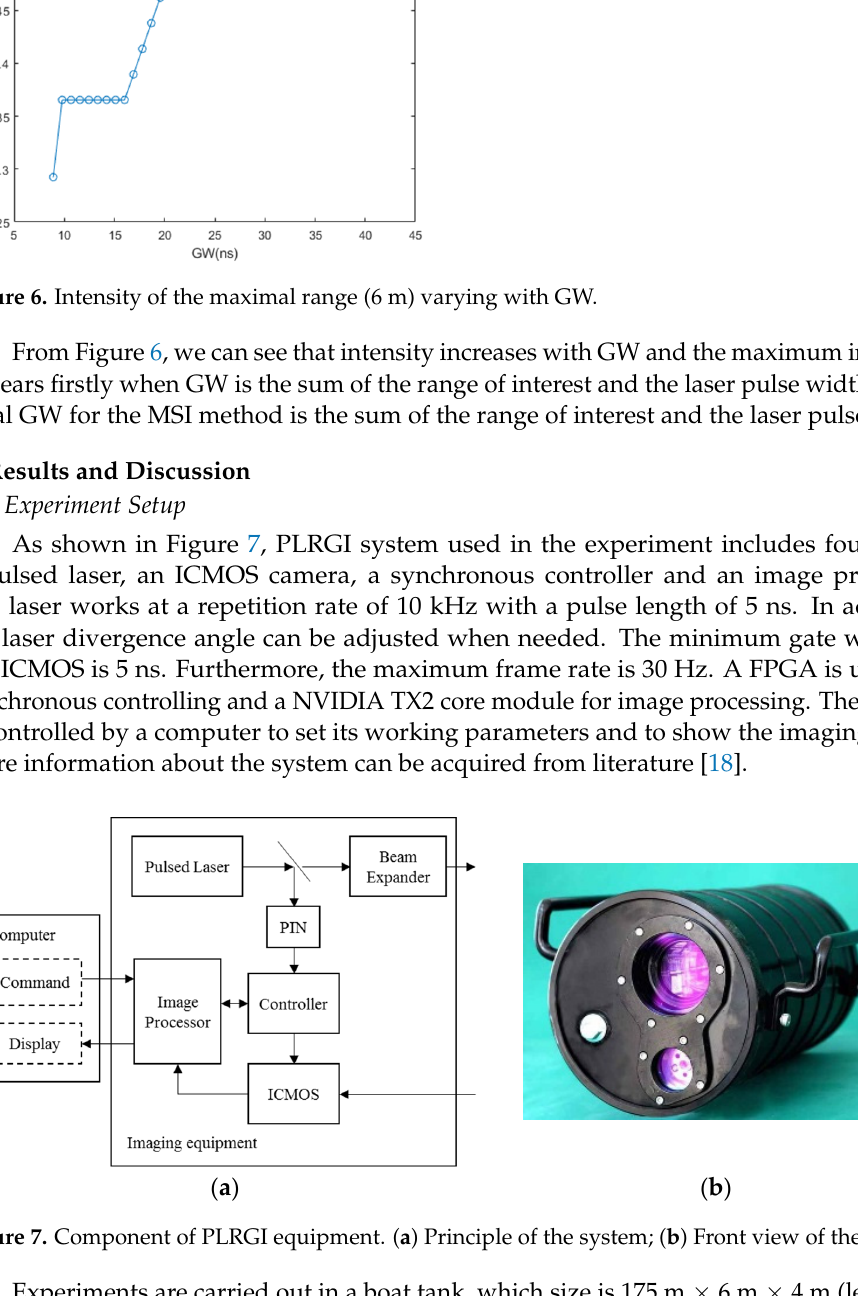
Figure 8. Experiment site. PLRGI system is placed at 1 m underwater.